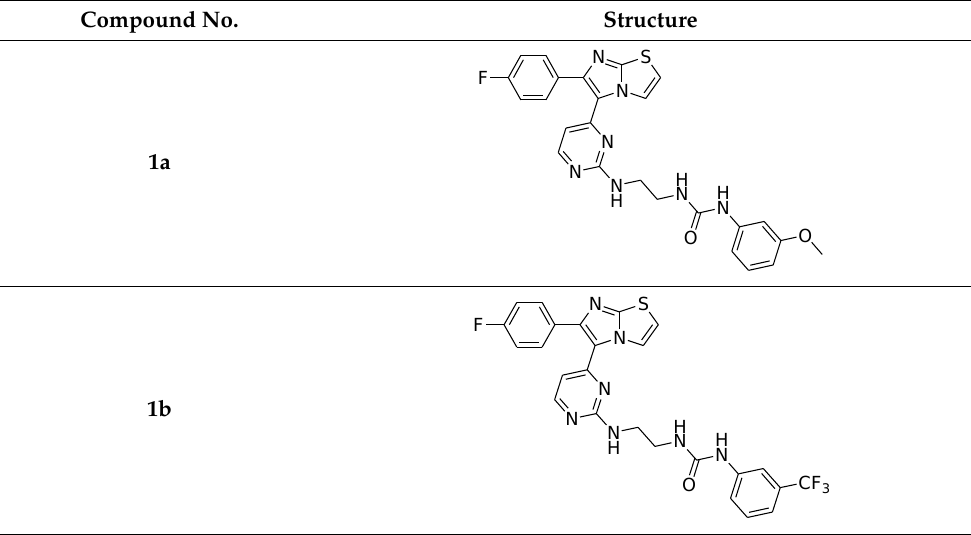
Table 2. Structures of the tested target compounds 1a – zd .